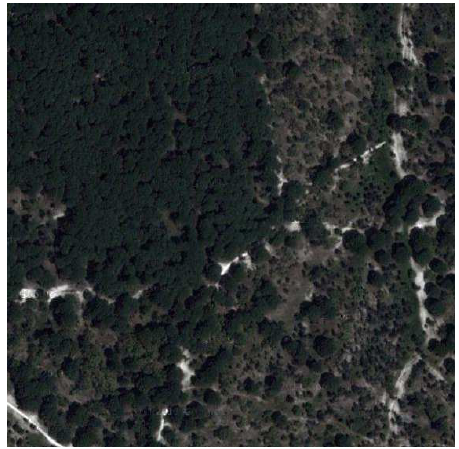
Figure 5: Visual image of a mixed continuous/scattered tree area of cork oak forest in southern Portugal.